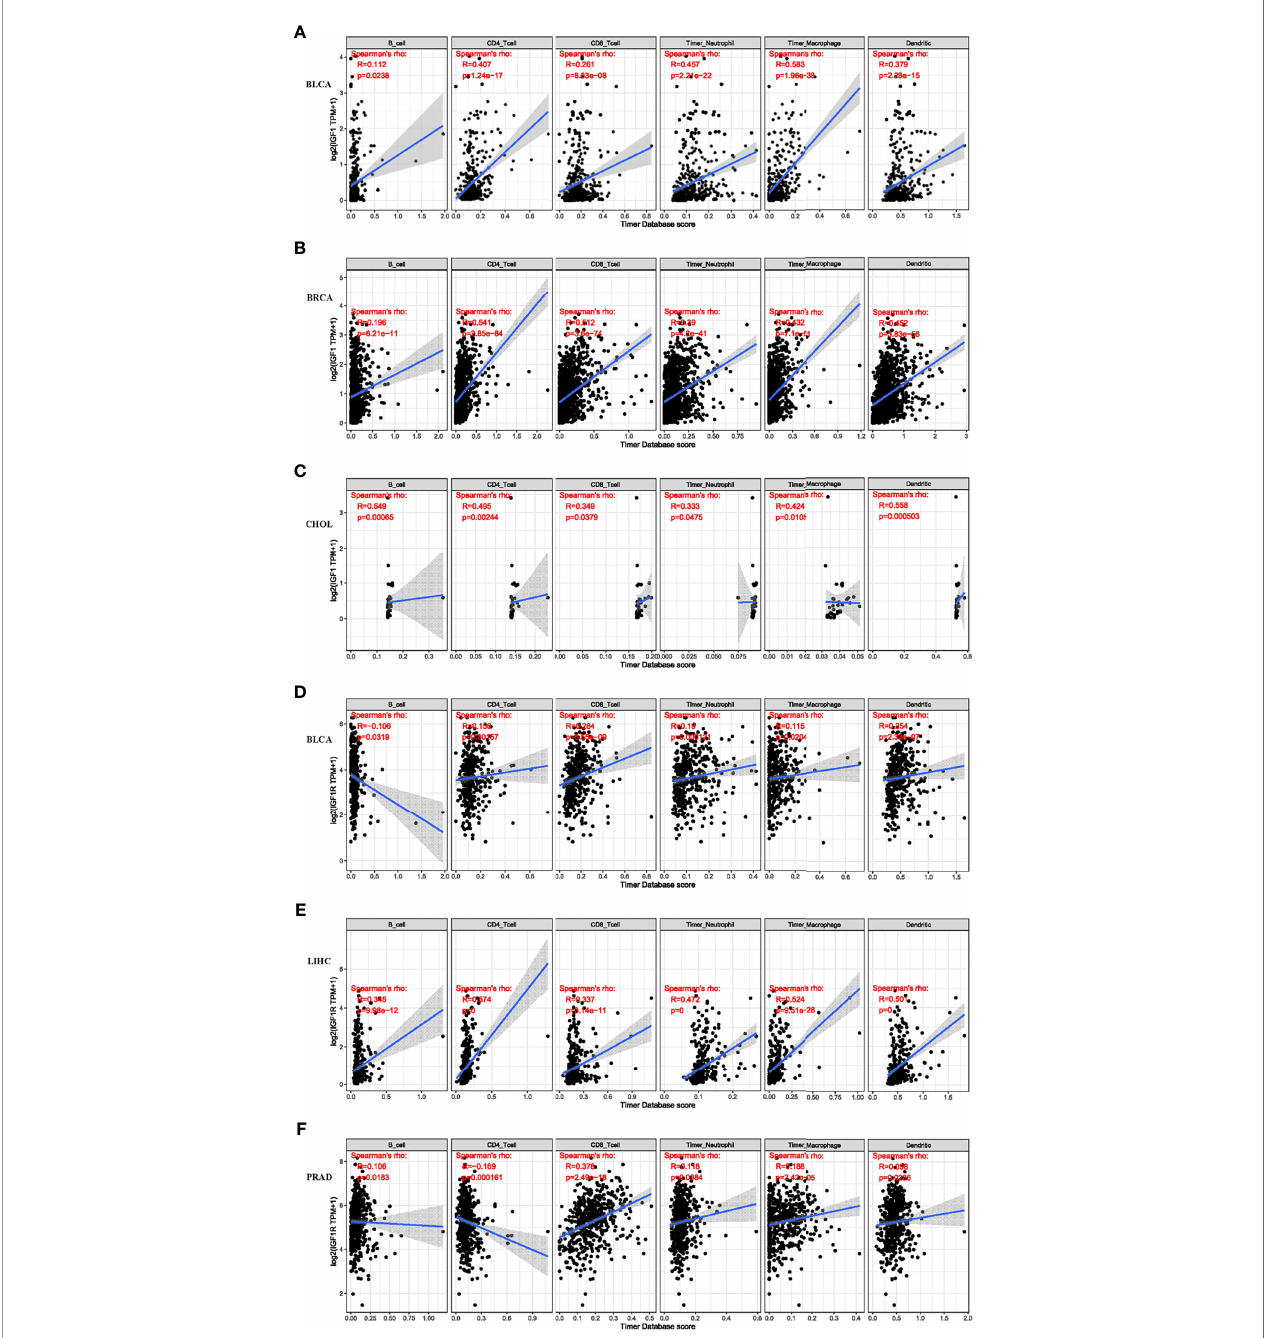
FIGURE 4 | Correlation of IGF-1 expression level with immune in fi ltration level in BLCA, BRCA, and CHOL. Correlation of IGF-1R expression level with immune in fi ltration level in BLCA, LIHC, and PRAD. (A – C) IGF-1 expression is signi fi cantly positively correlated with CD4+ T cell, dendritic cell, and macrophage in fi ltration in BLCA, BRCA, and CHOL. (D – F) IGF-1R expression is signi fi cantly positively correlated with CD4+ T cell, dendritic cell, and macrophage in fi ltration in BLCA, LIHC, and